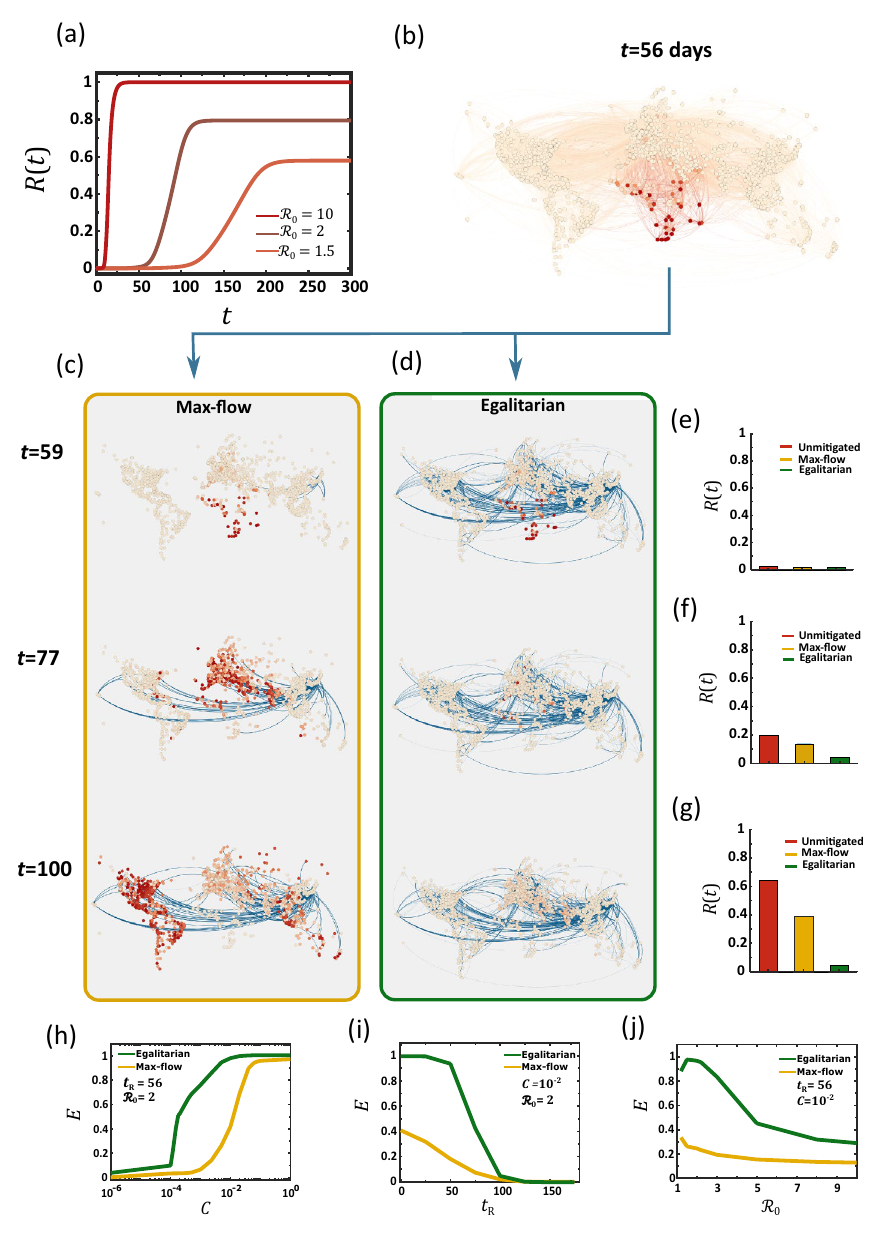
Figure 2. Outrunning a contageuous epidemic using max-flow vs. egalitarian dissemination. ( a ) The global coverage R ( t ) vs. t following an outbreak at Burundi (BJM) under three scenarios: severe (dark red R 0 = 10 ), intermediate (red, R R R 0 = 2 ) and mild (light red, 0 = 1.5 ). ( b ) The state of the epidemic (under 0 = 2 ) at t = 56 days, directly before drug dissemination begins. The local coverage r n ( t ) in each node and the flux of infected individuals along each link (air-route) are represented by their red color depth. ( c ) Max-flow dissemination : starting at t R = 56 we begin drug dissemination from Osaka (ITM) via max-flow; Eqs. (2)–(5). Drug fluxes L nm ( t ) (links) and drug availability q n ( t ) (nodes circumference) are represented by blue color depth. We observe a race between the therapeutic and the disease, both spreading along similar routes, ending in a significant fraction of infected individuals, as indicated by the prevalence of red nodes at t = 100 . ( d ) Egalitarian dissemination : under the same scenario, the egalitarian strategy of Eqs. (12)–(14) achieves a much more efficient mitigation, where by t = 100 , the epidemic is almost eliminated. ( e )–( g ) R ( t ) at the three time-points for the unmitigated spread (red), under max-flow (yellow) and under egalitarian (green). By t = 100 egalitarian has reduced the global coverage by a factor of ∼ 20 , from R ( t ) = 0.65 to R ( t ) = 0.04 , while max-flow has achieved a mere ∼ 1.5 factor reduction. Three crucial parameters may impact our mitigation: the global transportation capacity C , our response time t R and the severity of the contagion R 0 . ( h ) Mitigation efficiency E vs. C under egalitarian (green) and max-flow (yellow). The former achieves higher efficiency with orders of magnitude less resources. For example, egalitarian provides E = 0.8 under C ∼ 10 − 3 , as compared to C ∼ 10 − 1 , a two order of magnitude gap, required under max-flow for similar efficiency. ( i ) E vs. t R . Again, we find that egalitarian shows a significantly higher performance in the face of a late response. ( j ) E vs. R 0 , confirming, again, the consistent advantage of egalitarian mitigation. In each panel we vary one parameter and list the set values of the other